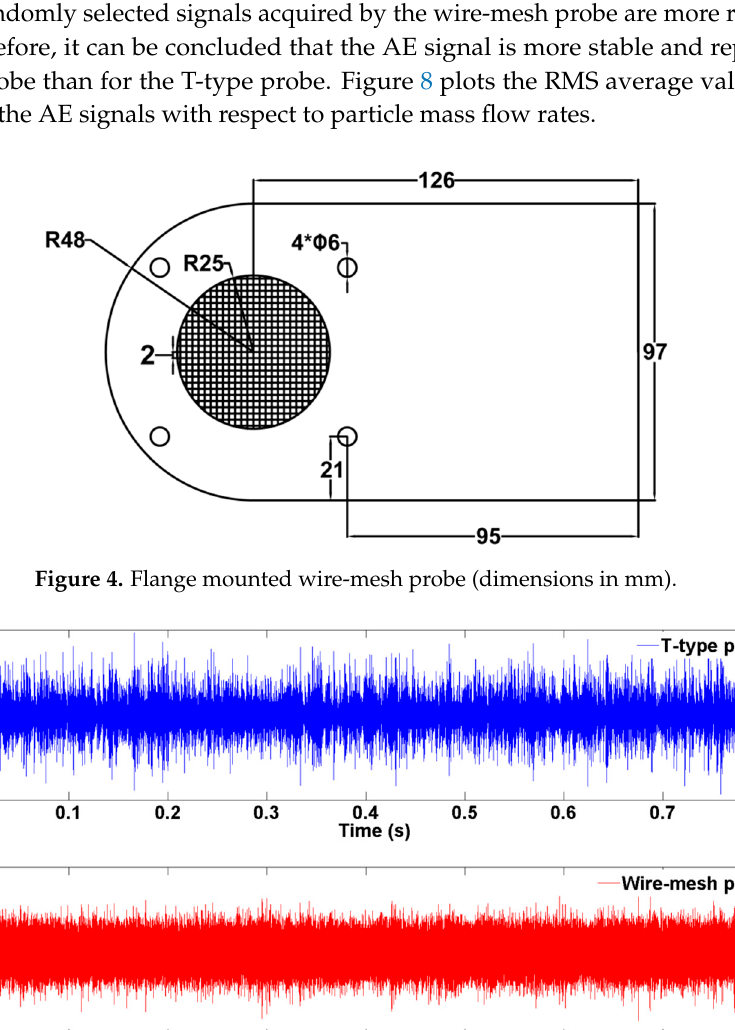
Figure 4. Flange mounted wire-mesh probe (dimensions in mm).